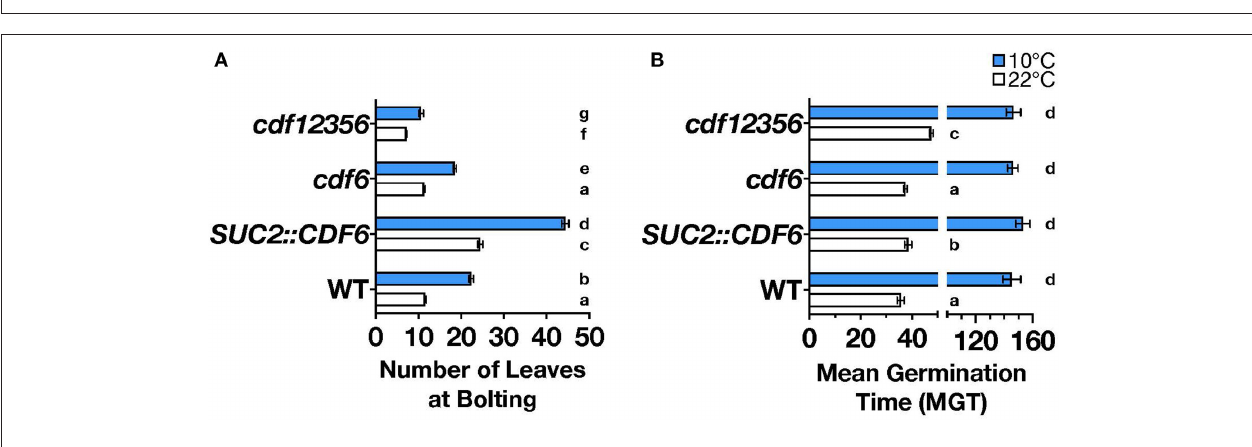
FIGURE 2 | CDF6 mis-expression alters flowering and seed germination. (A) The number of leaves at bolting for WT, SUC2::CDF6, cdf6 , and cdf12356 plants grown at constant 22 ◦ C (white bars) or 10 ◦ C (blue bars) in long-day conditions (mean values ± SE, n = 3 + , two-way ANOVA with Tukey’s multiple comparison test). (B) Mean germination time (MGT) for WT, SUC2::CDF6, cdf6, and cdf12356 plants grown in constant light (LL) at 10 ◦ C or 22 ◦ C with lowercase a-c letters indicating statistical significance at 22 ◦ C and d at 10 ◦ C (mean values ± SE, n = 4, one-way ANOVA with Dunnett’s multiple comparison